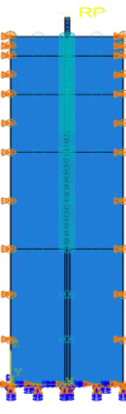
Figure 5. The 3-D FE model after completion of boundary conditions (cross-section view).